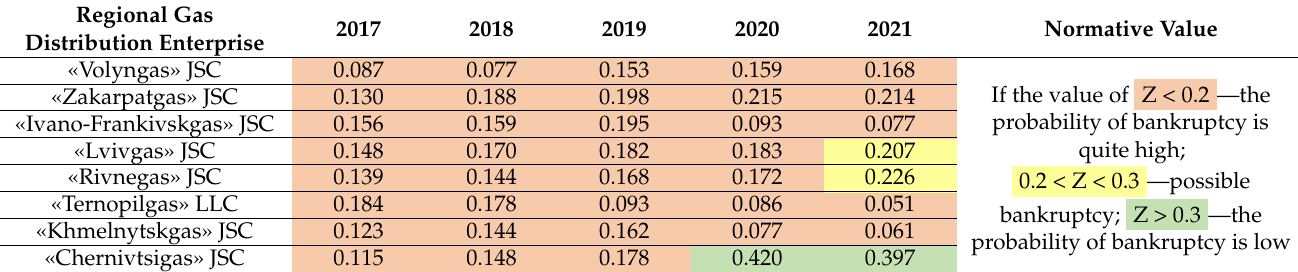
Table 7. Taffler’s model approbation.